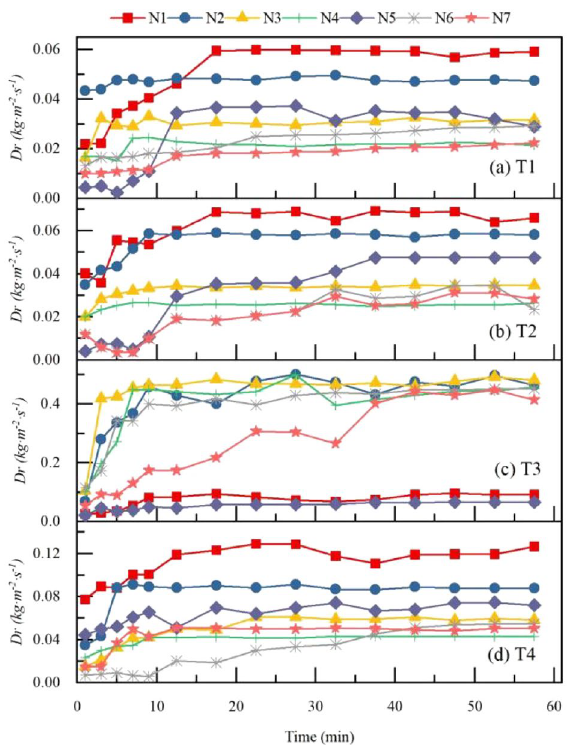
Figure 7. Time series of soil separation rate D r for seven types of litter layer. D r is the rate of soil separation; N1–N7 are treatments, see Table 2 for treatment specifics; T1 is slope 5°, rain intensity 60 mm·h −1 ; T2 is slope 10°, rain intensity 60 mm·h −1 ; T3 is slope 5°, rain intensity 120 mm·h −1 ; T4 is slope 10°, rain intensity 120 mm·h −1 .